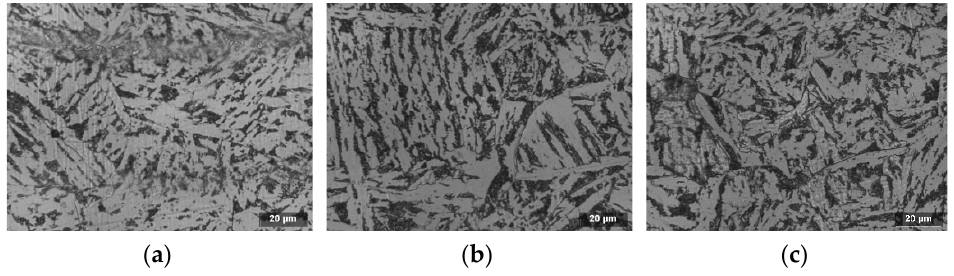
Figure 10. Microstructure in inner wall ( a ), central part ( b ) and outer wall ( c ) of hot-rolled pipe billet (HRPB).